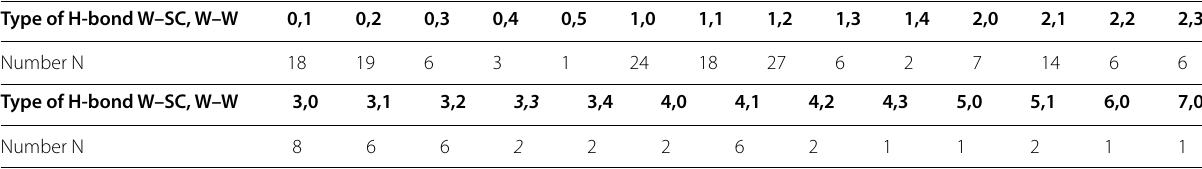
Eg 3,3 N 2 (italicized) means that 2 water molecules have a total of 3 hydrogen bonds to side chain atoms plus 3 hydrogen bonds to another water molecule (6 = hydrogen bonds in total)